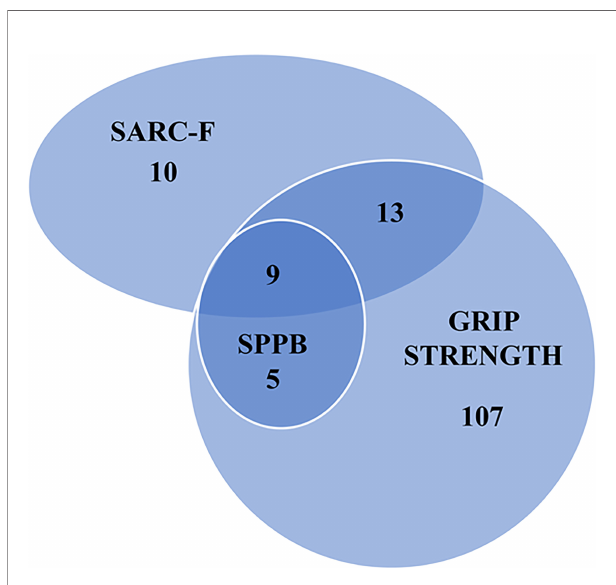
FIGURE 1 | Number of people with a pathologic value of a sarcopenia screening tool, hand grip strength and muscle performance test. SARC-F, Screening tool for sarcopenia; SPPB, Short Physical Performance